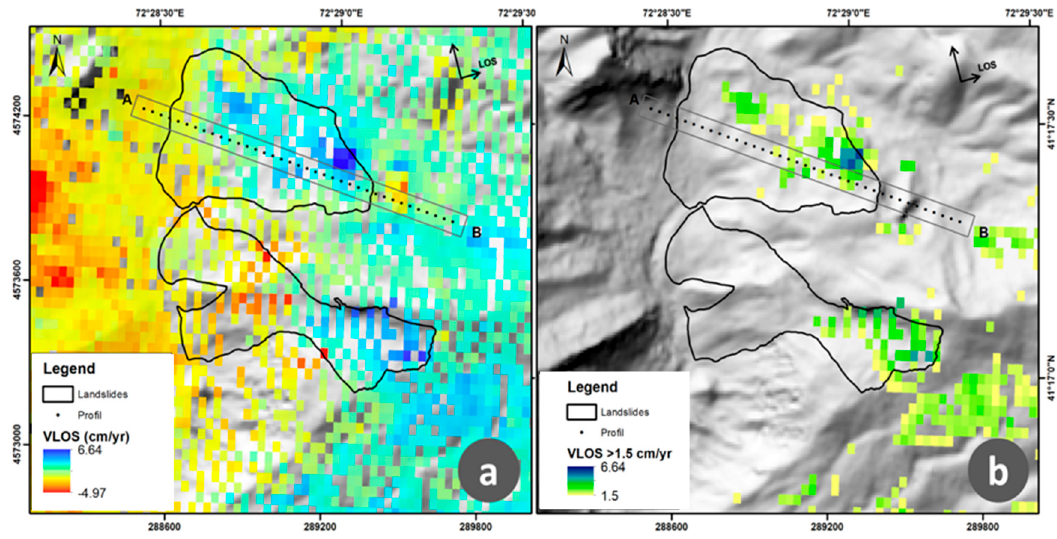
Figure 9. ( a ) Map of V LOS (in cm / year) resulting from the FASTVEL algorithm. The V LOS map is shown in transparency (20%) on the hillshade based on the 2011 TanDEM-X DEM. The black lines represent the limits of the Koytash and Tektonik, while the dotted line correspond to the central AB profile for which the V LOS were extracted; ( b ) Map of V LOS > 1.5 cm / year displayed on the 2011 TanDEM-X hillshade.